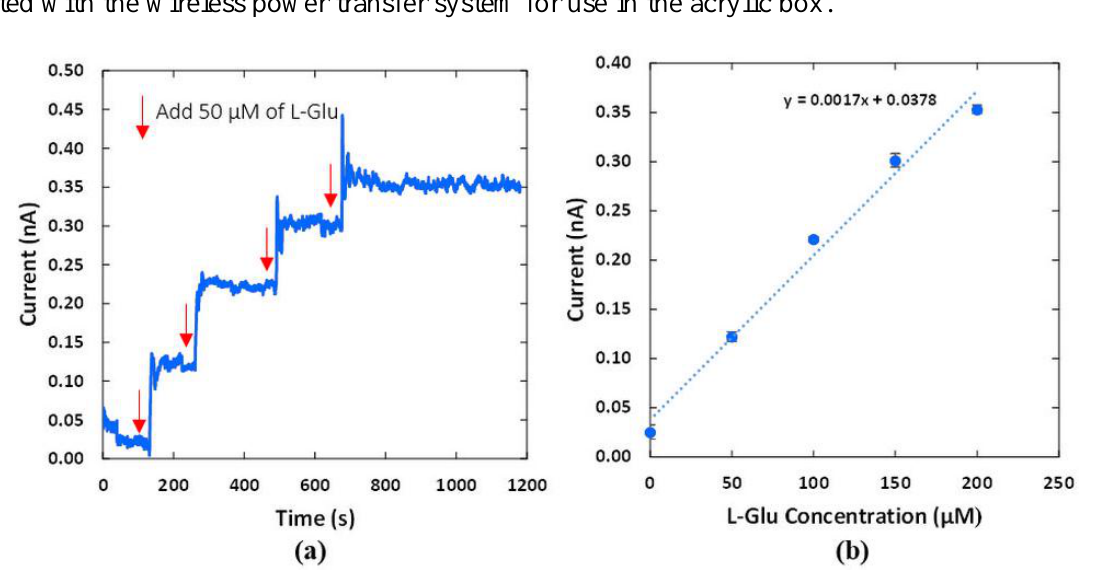
Figure 13. ( a ) Electrical current response of the L-Glu sensor which were wirelessly recorded with the neurotransmitter sensor module powered by the WPT system; ( b ) Calibration curve shows a sensitivity of 1.7 pA/µM with standard deviation (SD) less than 6.7